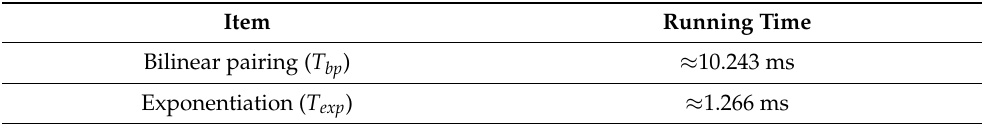
Table 4. Approximate execution time of evaluated